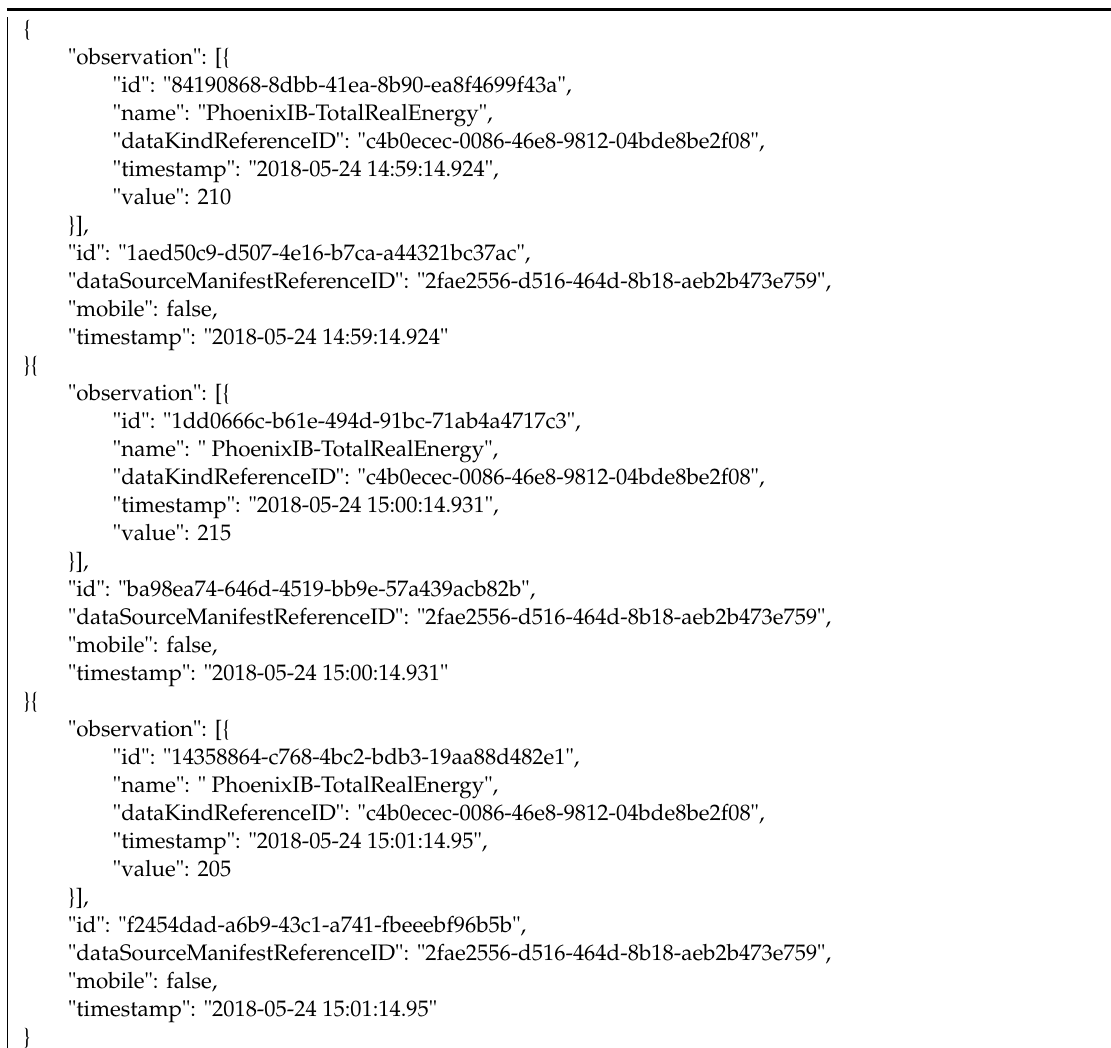
Table 7. Sample LiveDataSet for total real Energy Calculation based on the